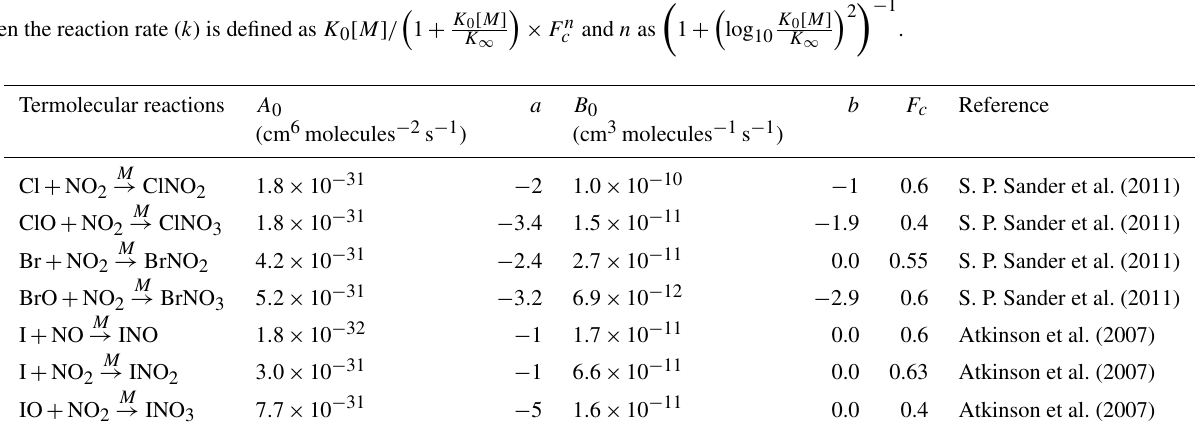
Table 3. Termolecular reactions for halogens species included in WRF-Chem. The lower pressure limit rate ( K 0 ) is given by A 0 × The high pressure limit ( K ∞ ) is given by B 0 × Then the reaction rate ( k ) is defined as K 0 [ M ] /